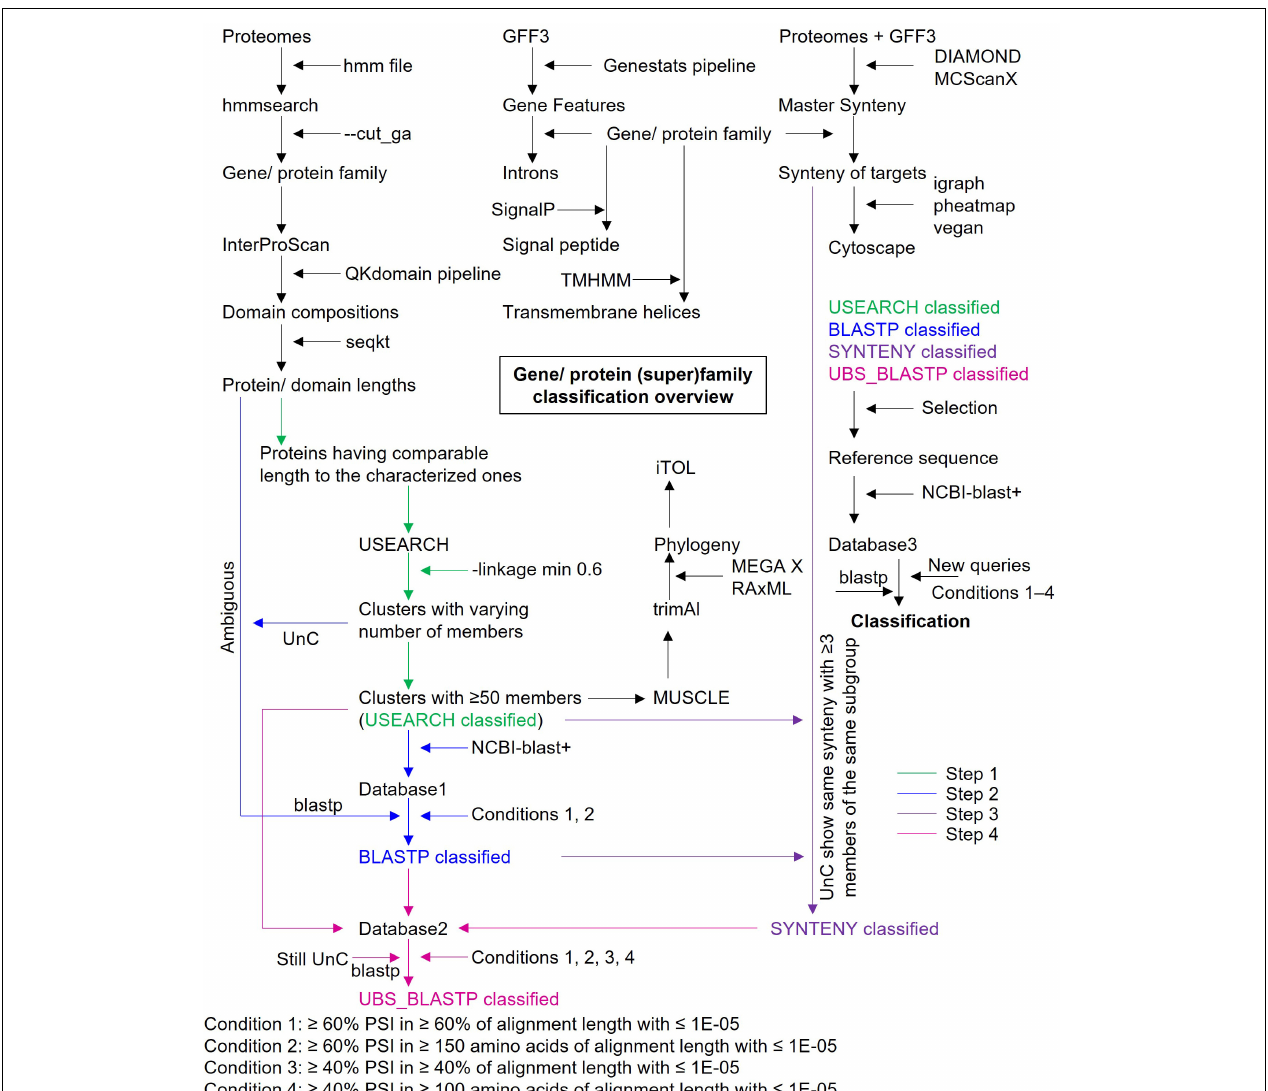
FIGURE 2 | Gene/protein (super) family classification overview. Major steps and bioinformatic tools involved in the classification workflow are highlighted. Reference sequences were selected based on their length and domain architecture from the USEARCH, BLASTP, SYNTENY, and UBS_BLASTP classified genes. UnC, Unclassified. Ambiguous, genes show short-length and/or non-standard domain architectures. UBS, USEARCH, BLASTP, and SYNTENY. The blastp conditions are applied sequentially where appropriate (i.e., condition 1 followed by 2 or condition 1 followed by 2, 3, and 4). The conditions 1/2 and 3/4 are used to determine the subgroups and groups of the gene/protein (super) family,